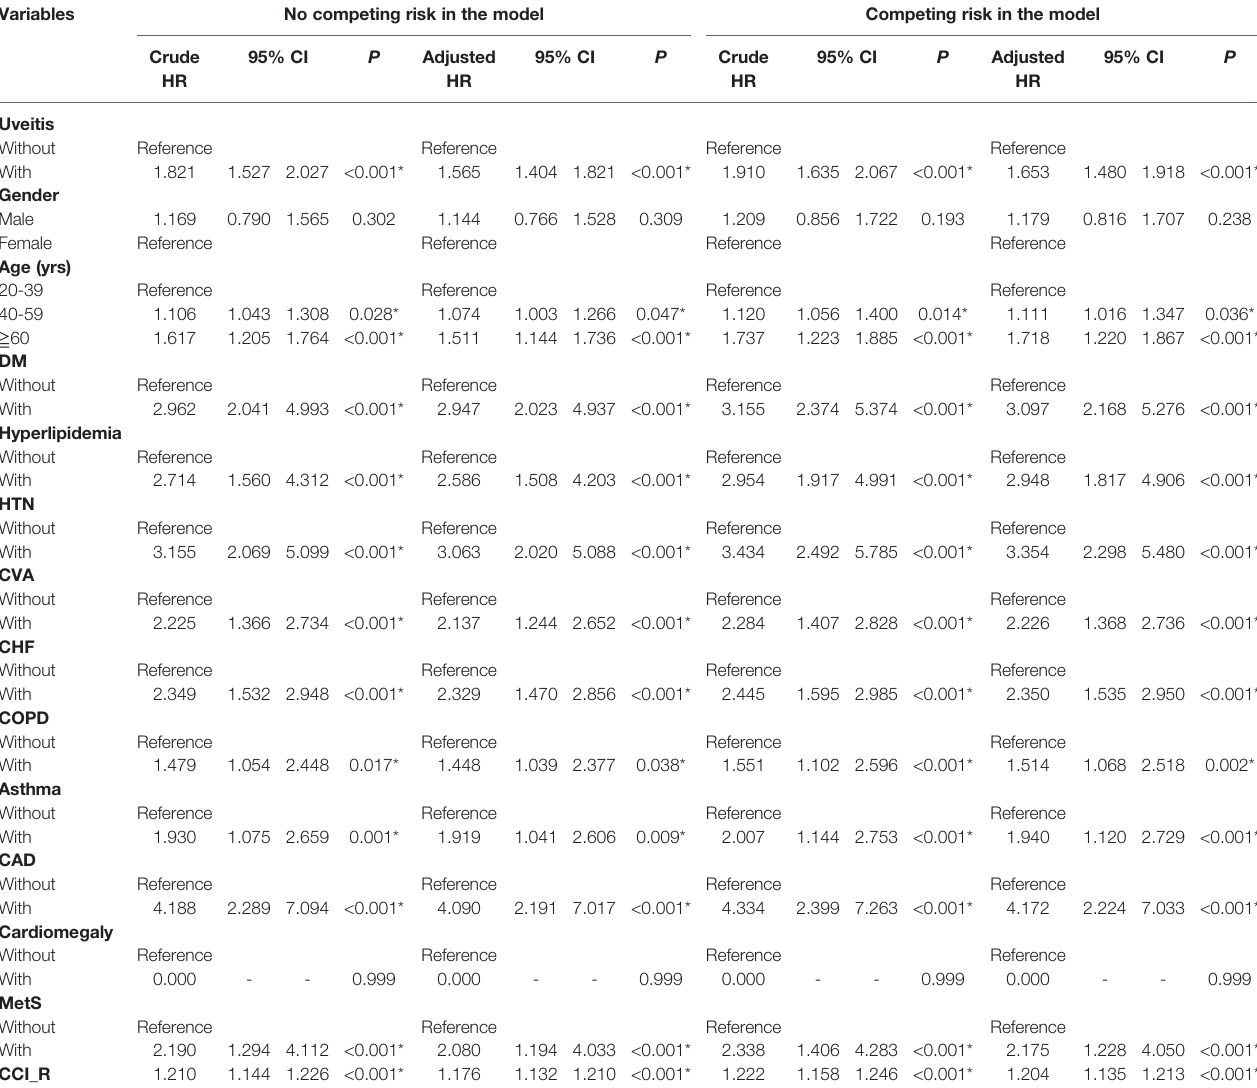
TABLE 2 | Factors for AMI evaluated by Cox regression with/without Fine & Gray ’ s competing risk model. Variables No competing risk in the model Competing risk in the model